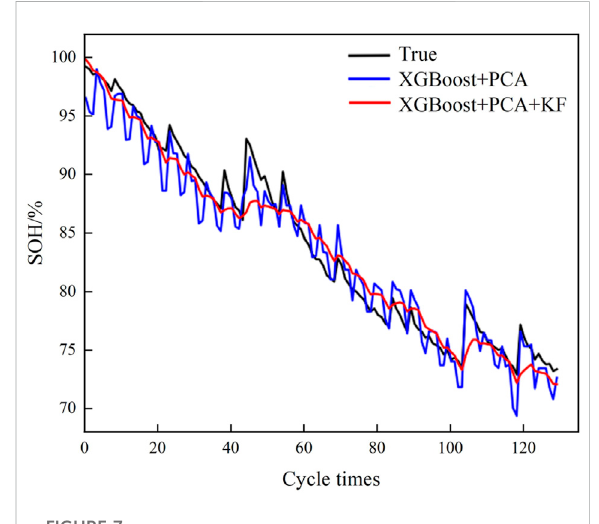
FIGURE 7 XGB-KF model to estimate SOH results for Li-ion cells.